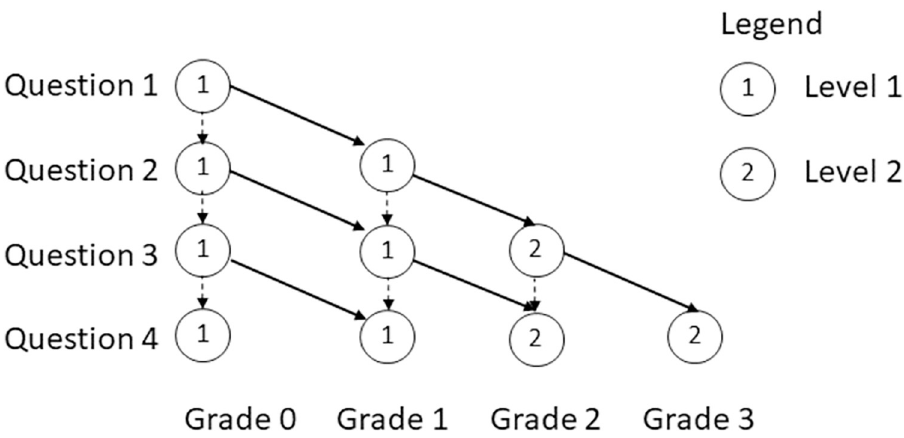
Fig 1. Representation of the CAT model. Solid and dotted arrows indicate the path of correct and incorrect answers respectively. Grades are represented at the bottom of the figure, In the Y axis there is the number of questions and in the circles there is the level of the